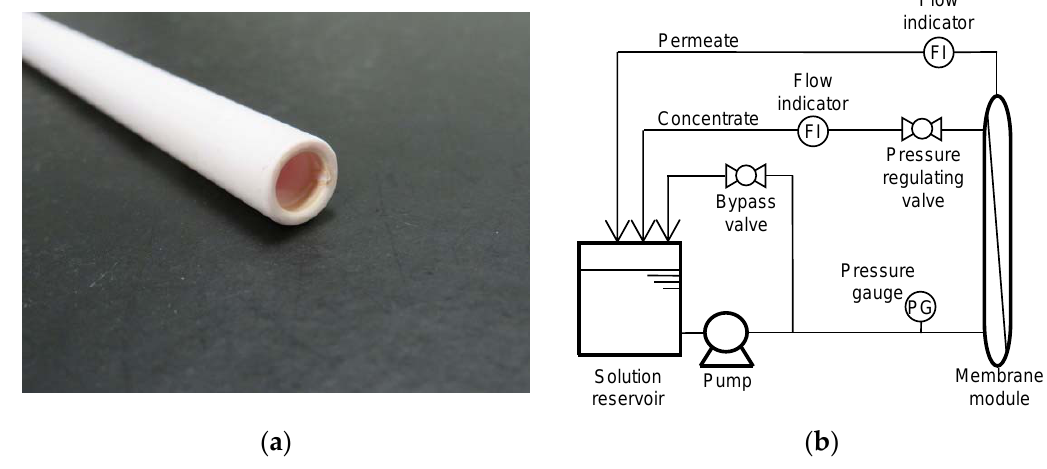
Figure 1. ( a ) Photo of the nanofiltration (NF) ceramic membrane and ( b ) schematic diagram of the cross ‐ flow NF filtration system.